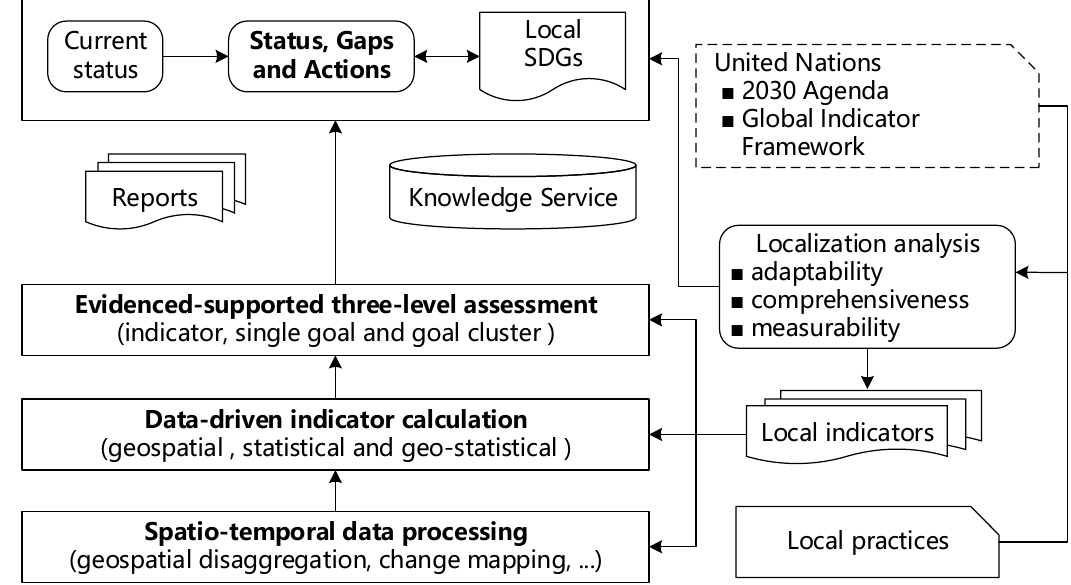
Figure 1. Methodology for a comprehensive measurement of progress toward Sustainable Development Goals (SDGs).